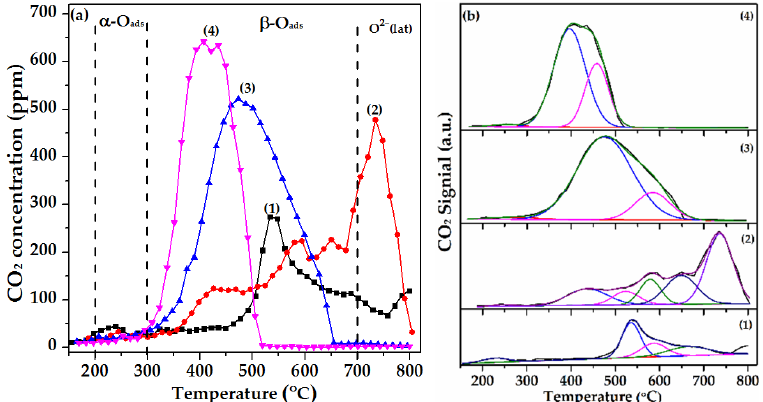
Figure 8. Soot-TPR curves ( a ) and peak fitting ( b ) of as-prepared catalysts: MnCo 2 O 4 -P (1), Mn 0.9 K 0.1 Co 2 O 4 -P (2), Mn 0.8 K 0.2 Co 2 O 4 -P (3), Mn 0.7 K 0.3 Co 2 O 4 -P Table 3. The temperature of each peak in the Soot-TPR and H 2 -TPR curves over as-prepared mon- olith catalysts.